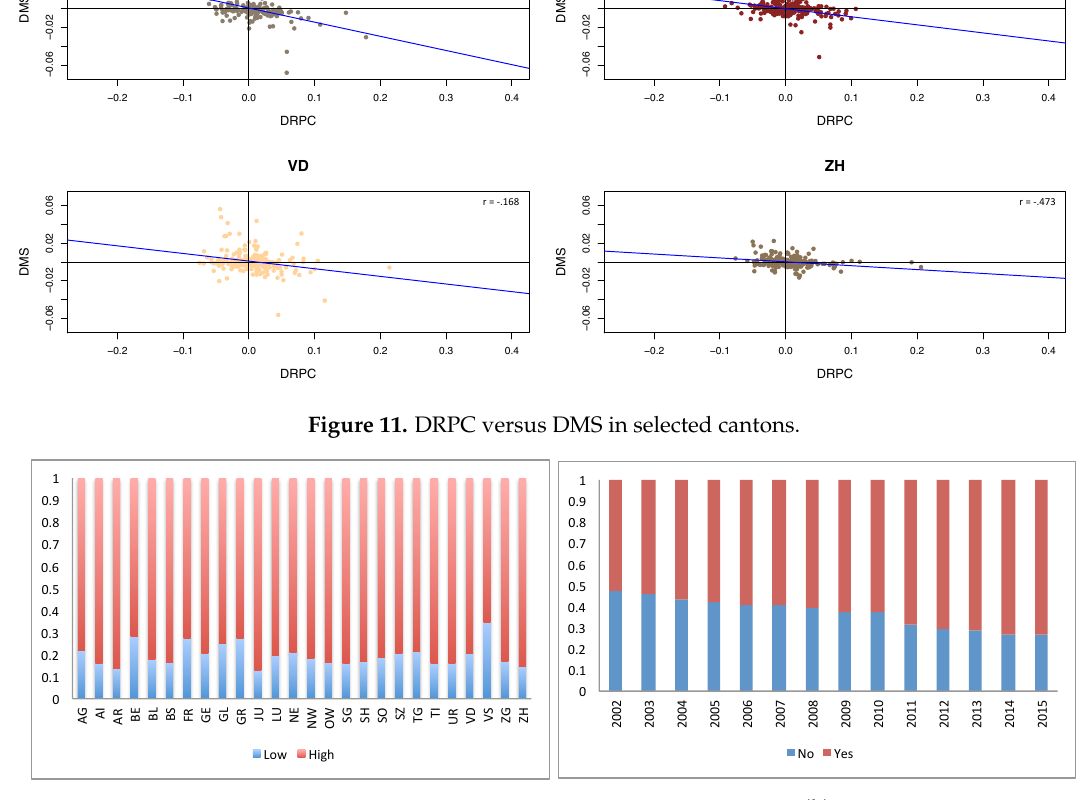
Figure 12. Group distribution and satisfaction distribution. ( a ) Satisfaction distribution per canton; ( b ) Group distribution per